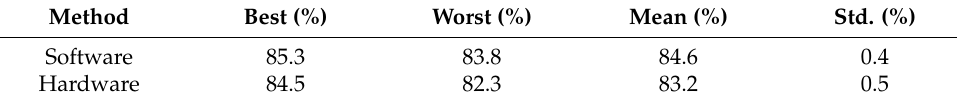
Table 6. Accuracy results for the VSBD dataset (over 20 iterations).